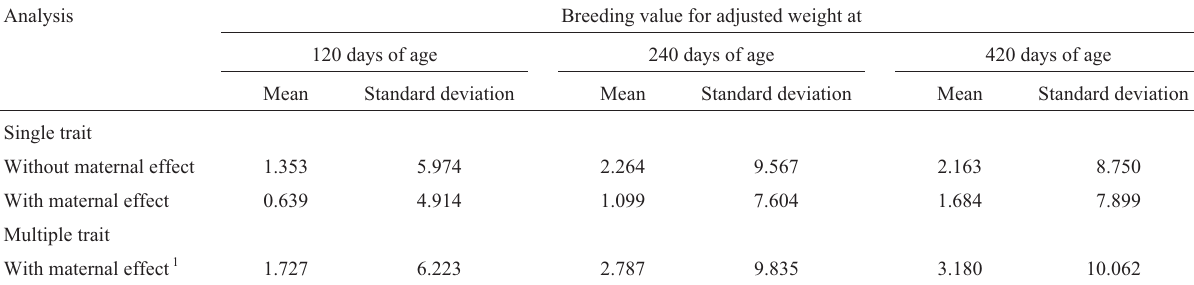
Table 5 - Means and standard deviations of the breeding values of sires for the adjusted weights at 120, 240 and 420 days of age obtained by single trait analyses in the model with and without maternal effects, and multiple trait analyses for adjusted weights at different ages with maternal effects in the